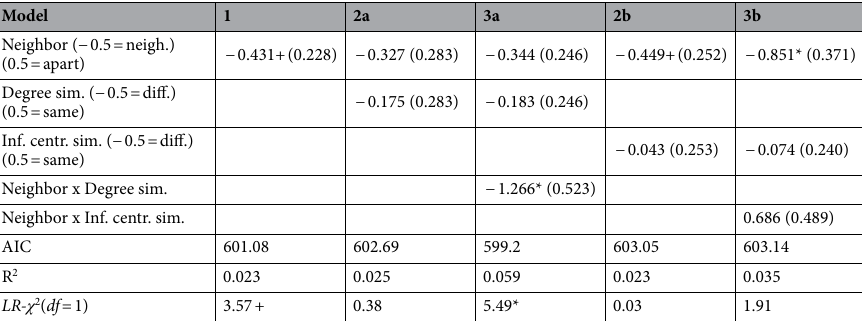
Table 1. Cox proportional hazards models of convergence speed in the conflict scenario. SE in parenthesis. + p < 0.1; *p < 0.05.